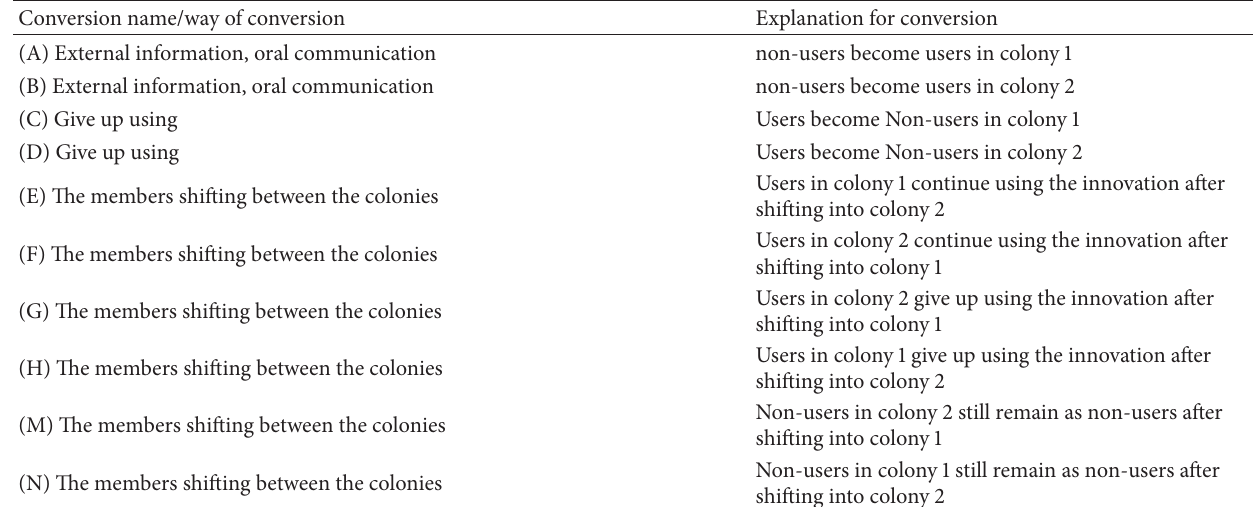
Table 1: The explanation for conversion relation.